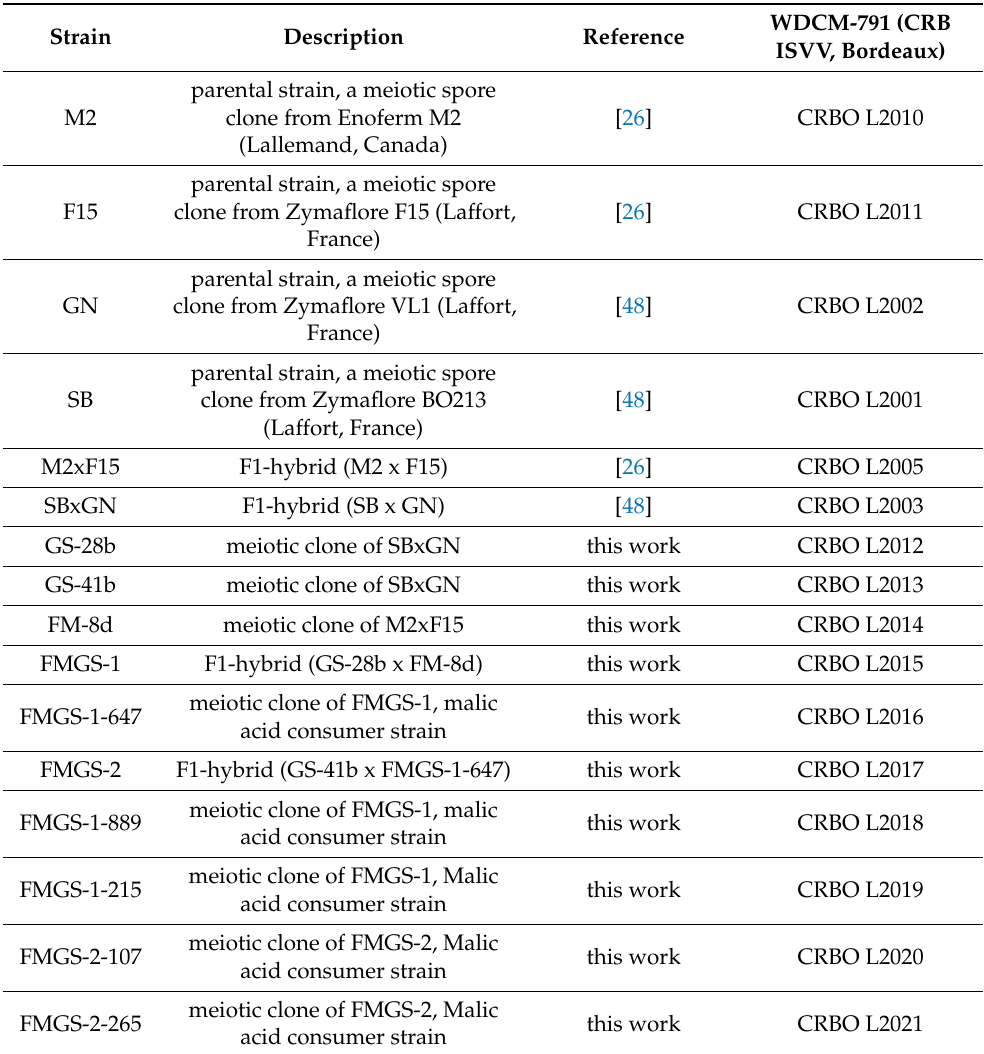
Table 1. Main Saccharomyces cerevisiae strains